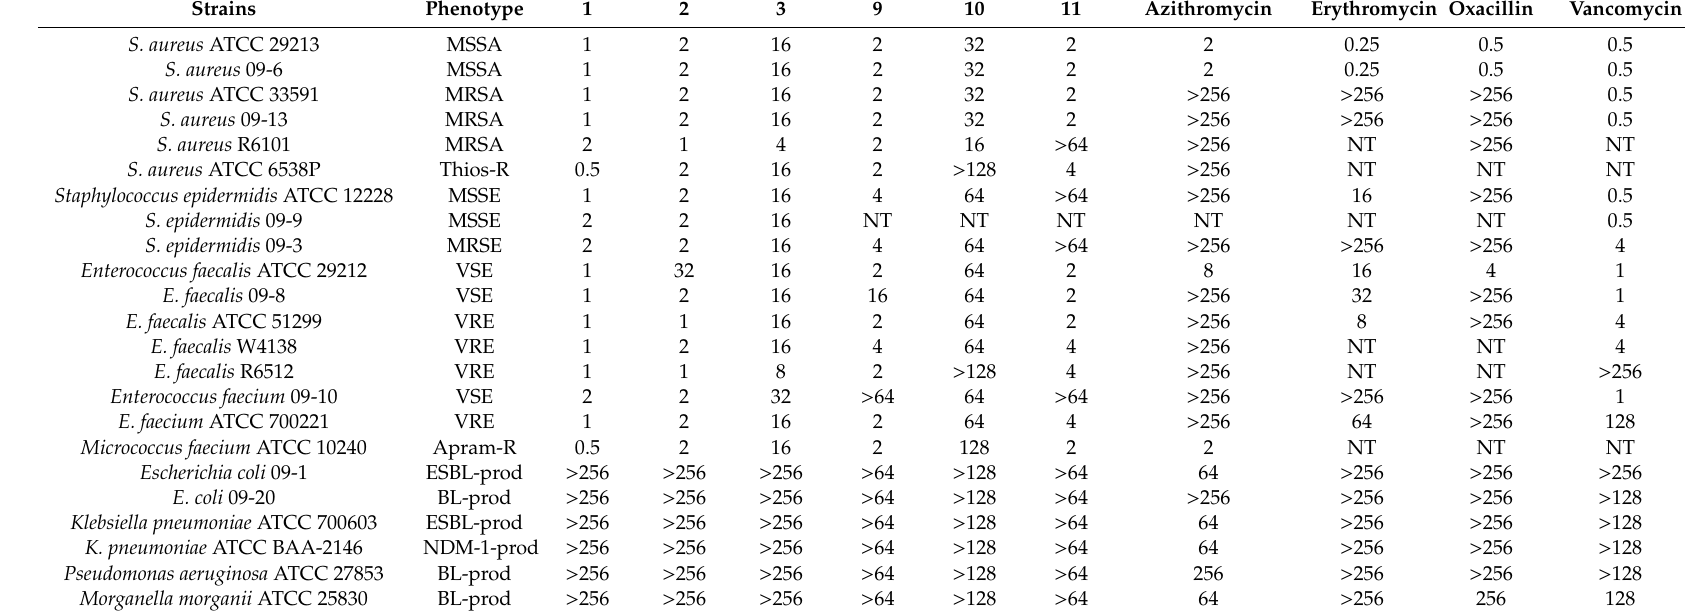
Table 1. Antimicrobial bioassay results (MIC, µ g / mL) for 1 – 3 , 9 , 10 , and 11 a